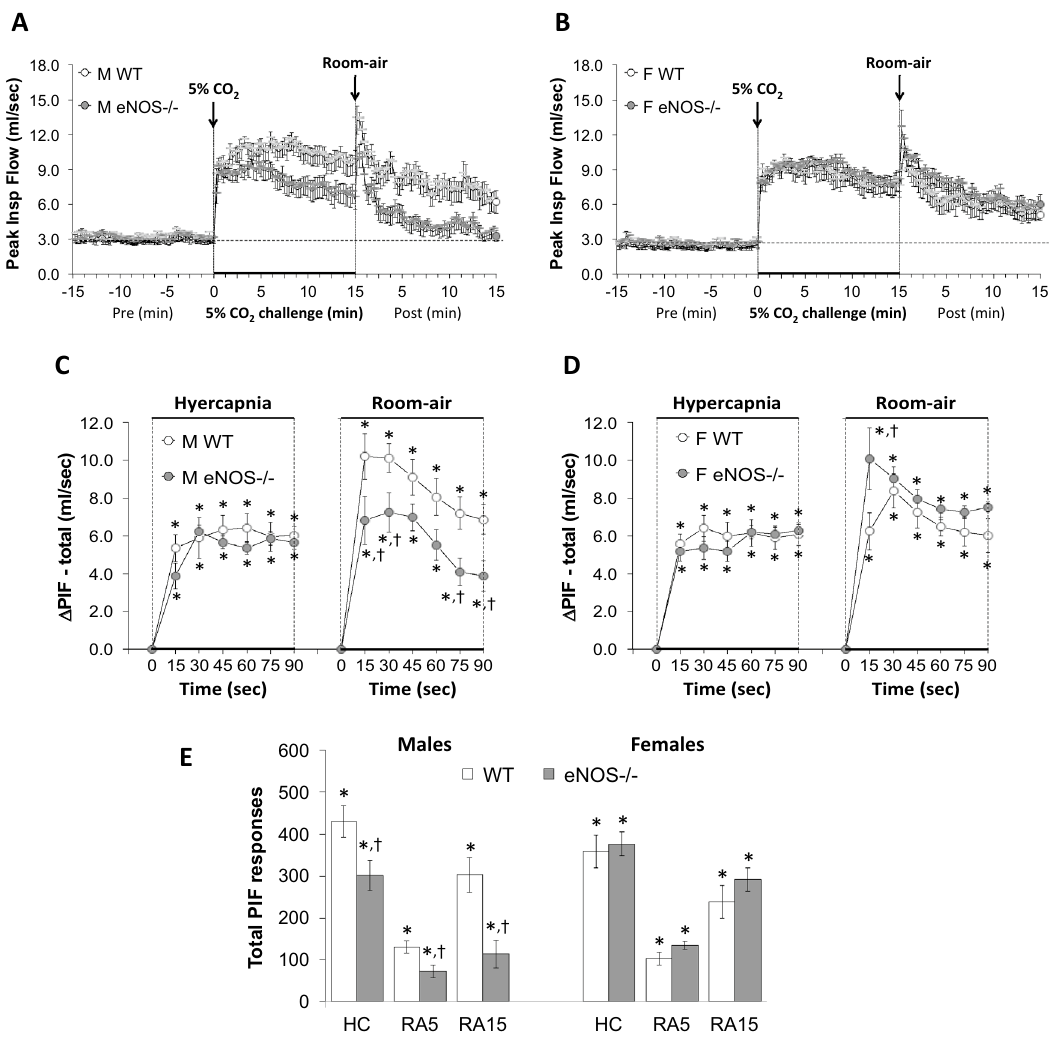
Figure 8. Panels ( A ) and ( B ) Peak Inspiratory Flow (PIF) values before, during a hypercapnic (HC) gas challenge (5% CO 2 , 21% O 2 , 74% N 2 ) and upon return to room-air in male (M) and female (F) wild-type (WT) and eNOS knock-out (eNOS-/-) mice. Panels ( C ) and ( D ) Arithmetic changes in PIF in male and female WT and eNOS-/- mice during the first 90 s of exposure to HC challenge and the first 90 s upon return to room-air. Panel ( E ) Total changes in PIF in male and female WT and eNOS-/- mice during HC challenge and during the first 5 min (RA5) and entire 15 min (RA15) return to room-air. The data are presented as mean ± SEM. * P < 0.05, significant change from pre-values. † P < 0.05, eNOS-/- versus WT within each female mice (Panels B and D). After the initial 90 s, TV/Ti values recovered to baseline values more quickly in male eNOS-/- mice compared to WT males, than female eNOS-/- mice compared to WT females, therefore the total responses during the 5 min and 15 min time periods were significantly smaller in eNOS-/- males than WT males (Panel E, columns RA5 and RA15). There was no difference in total room-air responses in WT and eNOS- /- female mice (Panel E, columns RA5 and RA15). As seen in Fig. 7, HCC elicited robust increases in expiratory drive (TV/Te) in male and female WT and eNOS-/- mice (Panels A and B). The rates of reaching the initial increases in TV/Te during HCC were similar in male WT and eNOS-/- mice and female WT and eNOS-/- mice (Panels C and D). The total (arithmetic) responses (Panel E, column HC) were similar in WT and eNOS-/- male and female mice. Upon return to room-air, TV/Te values returned to baseline values at an initial faster rate in eNOS-/- males than in WT males (Panels A and C) and returned to baseline values at a similar initial rate in WT and eNOS-/- female mice (Panels B and D). After the initial 90 s, TV/Te values reached baseline values more quickly in male than female eNOS-/- mice, such that the total responses over the 15 min period were signifi- cantly smaller in eNOS-/- males than in WT males (Panel E, column RA15). There was no difference in total room-air responses in female WT and eNOS-/- mice (Panel E, columns RA5 and RA15). Peak inspiratory flow (PIF) and peak expiratory flow (PEF). As seen in Fig. 8, HCC elicited robust increases in PIF in male and female WT and eNOS-/- mice (Panels A and B). The rate of reaching the initial